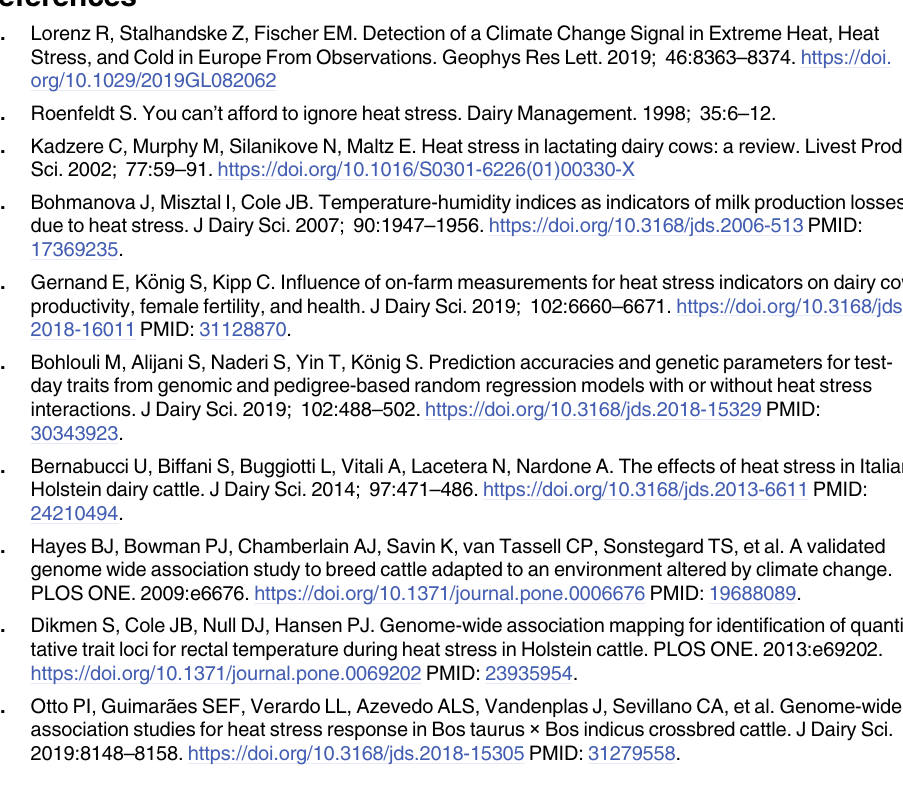
S1 Fig. Inflation factors for main effects from GWAS models with (GWA_wHS) and with- out genotype by heat stress interaction (GWA_nHS) during the last eight weeks of preg- nancy. Dotted line = inflation factor of 1.05; TMY = first test-day milk yield; TFP = first test- day fat percentage; TFY = first test-day fat yield; TPP = first test-day protein percentage; TPY = first test-day protein yield; TSCS = first test-day somatic cell score; LMY = first lactation milk yield; LFP = first lactation fat percentage; LFY = first lactation fat yield; LPP = first lacta- tion protein percentage; LPY = first lactation protein